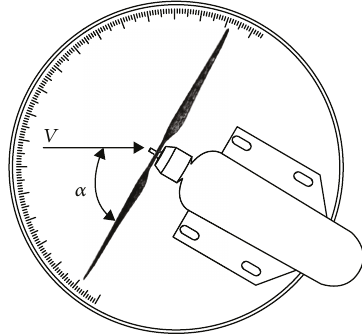
Figure 4: De fi nition of the angle of attack.